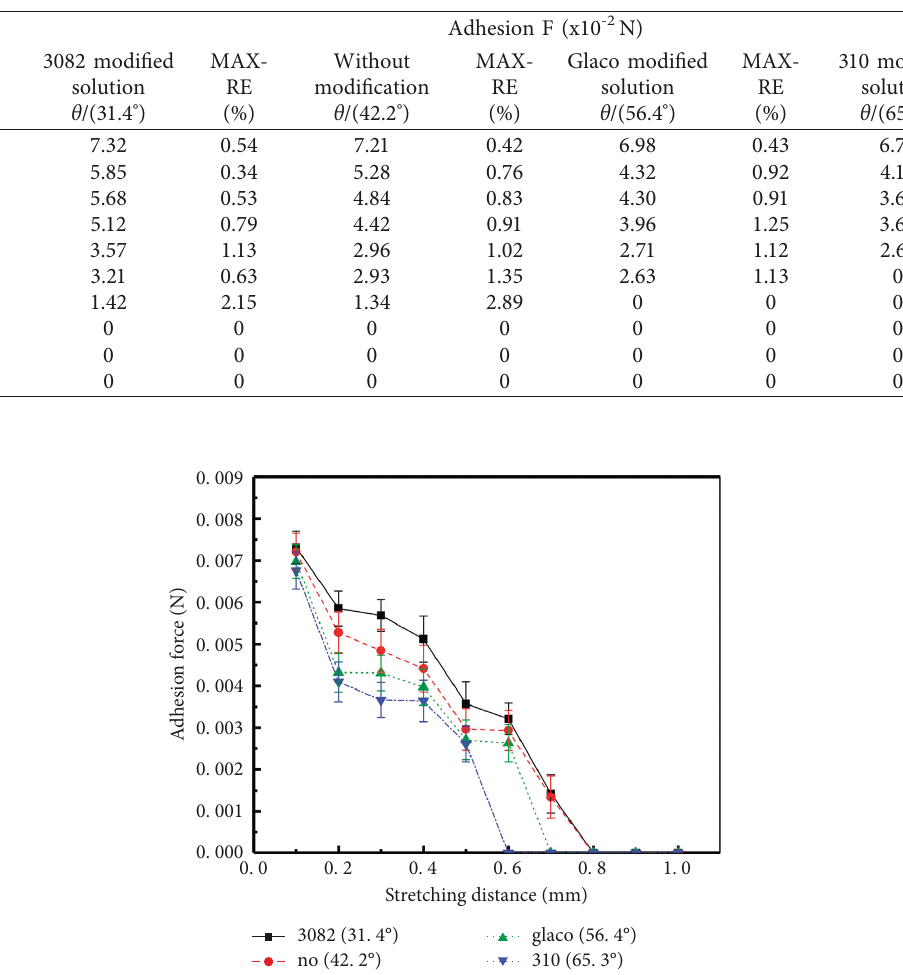
Table 7: Experimental values of adhesion under different contact surfaces.